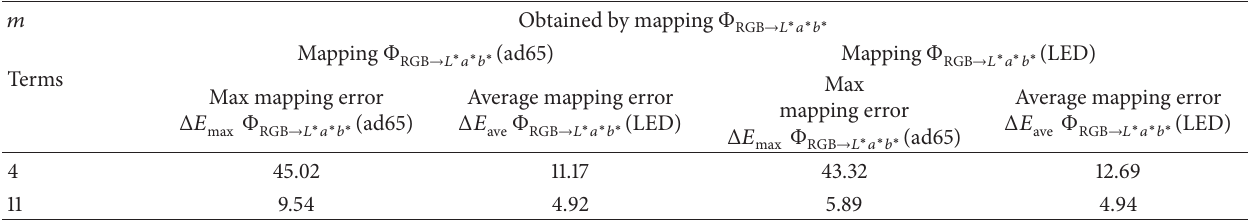
Table 3: The accuracy comparison Δ𝐸 𝑖 ( Φ RGB →𝐿 ∗ 𝑎 ∗ 𝑏 ∗ ) in CIE- 𝐿 ∗ 𝑎 ∗ 𝑏 ∗ color space obtained by mapping coefficient matrix Φ RGB →𝐿 ∗ 𝑎 ∗ 𝑏 ∗ . 𝑚 Obtained by mapping Φ